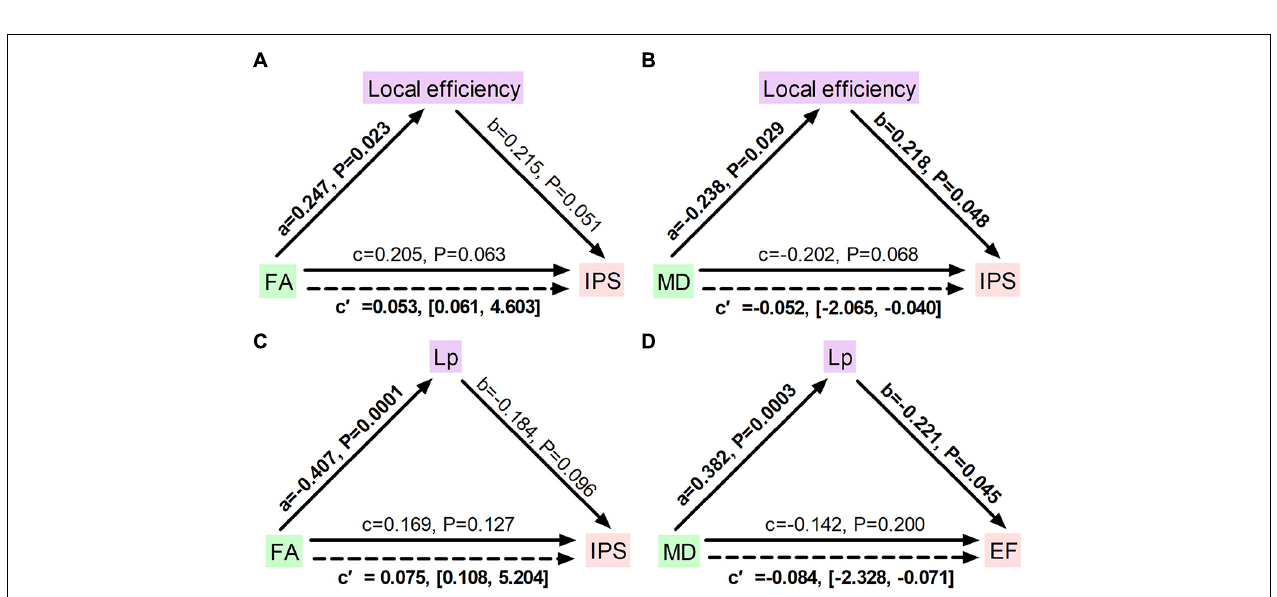
FIGURE 4 | The significant correlations between cognitive performances and network parameters in patients with ILA. (A–D) Within the ILA group, the executive function ( Z scores) correlated positively with the nodal efficiency of the MFG.R, IFGoperc.R, PreCG.R, and THA.L. (E,F) The nodal efficiency of the MFG.R correlated significantly with the episodic memory ( Z scores) in patients with ILA, of the IFGoperc.R with the processing speed ( Z scores). For the abbreviations of nodes, see Supplementary Table 2 . ILA, ischemic leukoaraiosis.